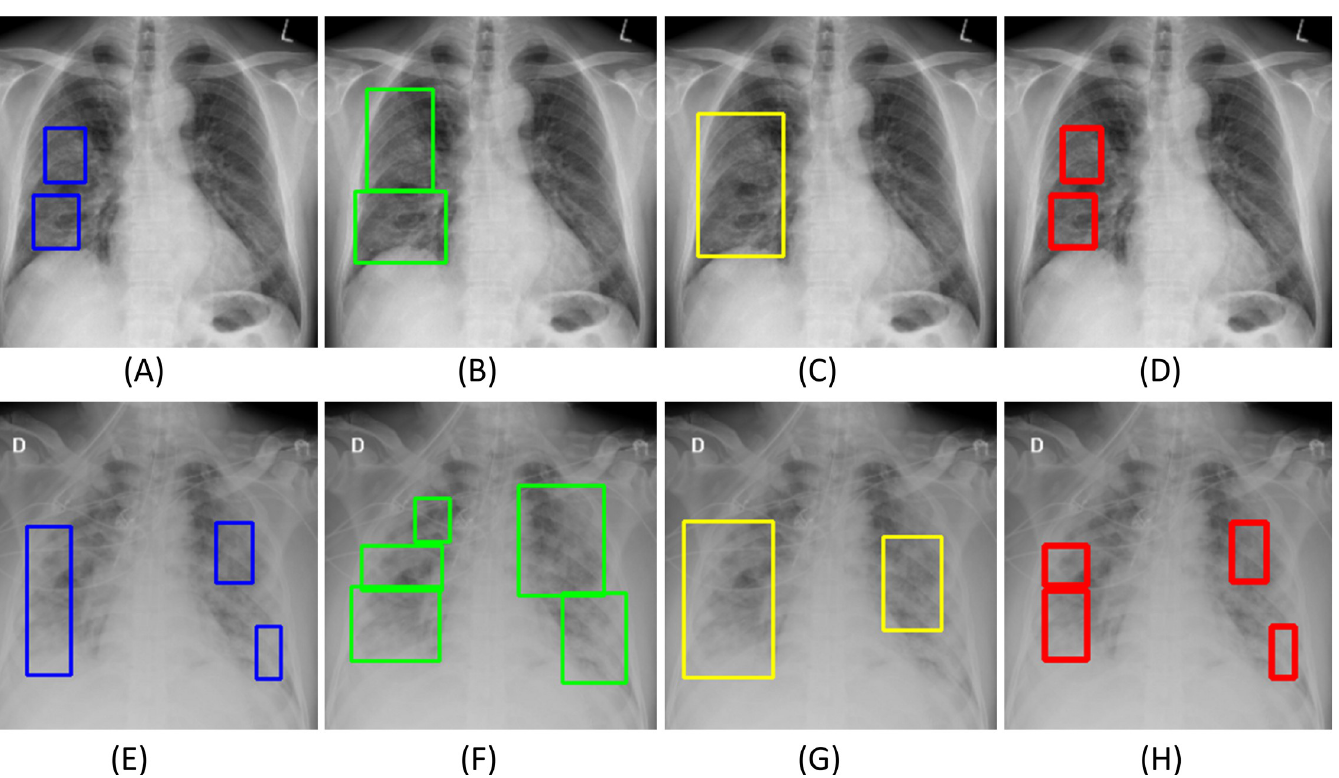
Fig 14. Sample CXRs from two different patients (rows A-D and E-H, respectively) show ROI annotations generated. (A) and (E) Rad-1 (in blue); (B) and (F) Rad-2 (in green); (C) and (G) Top-3 ensemble using STAPLE-generated consensus ROI (program) (in yellow); (D) and (H) STAPLE-generated consensus ROI annotation (in